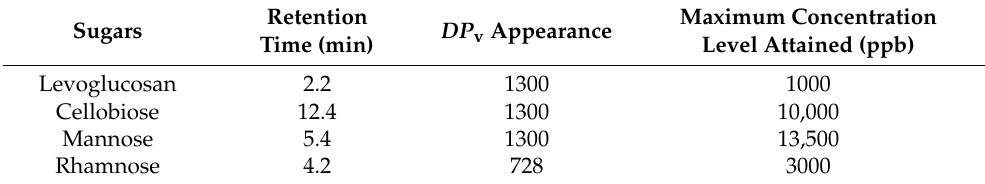
Table 2. Detection of sugars in